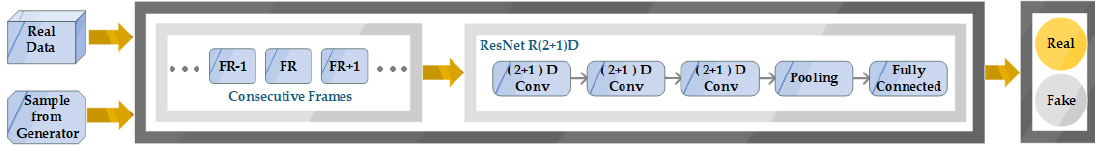
Figure 5. Architecture of the temporal discriminator.